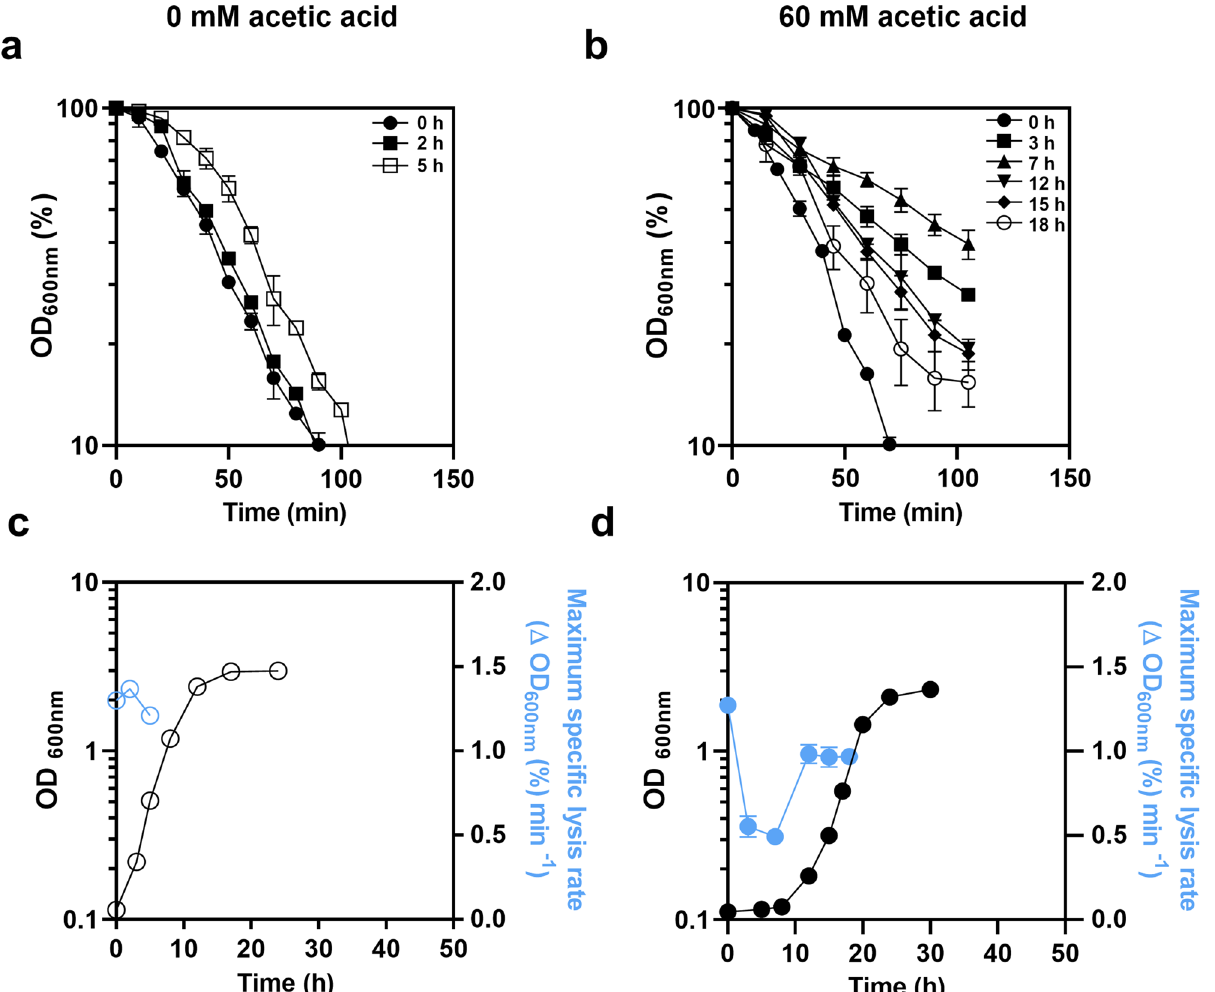
Figure 1. Effect of lyticase in yeast cell wall during the growth curve in the absence or presence of acetic acid stress. Decrease of the OD 600nm of S. cerevisiae BY4741 cell suspensions (in %) following the addition of lyticase, as described in M&M. Cells were harvested at 0 h (filled circle), 2 h (filled square), 5 h (open square) of cultivation in MM4 pH 4.0 not supplemented with acetic acid ( a ) and at 0 h (filled circle), 3 h (filled square), 7 h (filled triangle), 12 h (filled down pointing triangle), 15 h (filled rhombus) and 18 h (open circle) of cultivation in the presence of 60 mM acetic acid at 4.0 ( b ).The maximum specific lysis rates, determined based on data in ( a ) and ( b ) for yeast cells harvested at the selected time-points, are shown during cultivation in the absence ( c ) or presence of acetic acid ( d ). The initial biomass concentration used corresponded to culture OD 600nm of 0.1 ± 0.01. Data are means from at least three independent experiments and bars represent standard